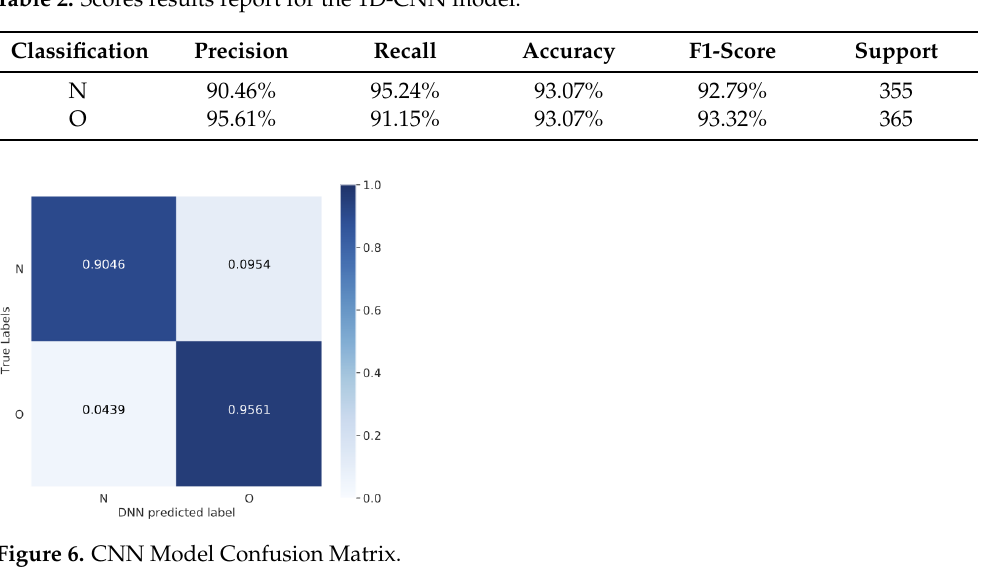
Table 2. Scores results report for the 1D-CNN model.